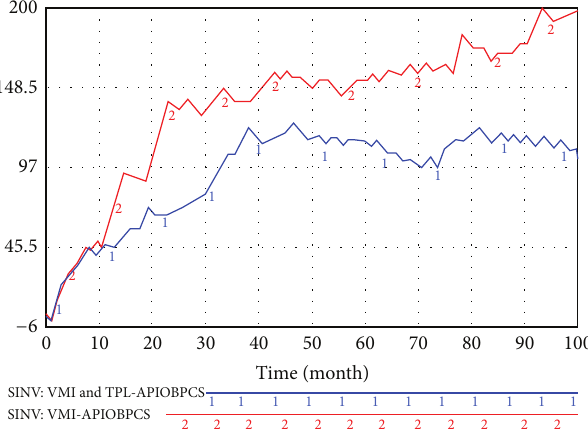
Figure 22: Fluctuation diagram of system inventory level.